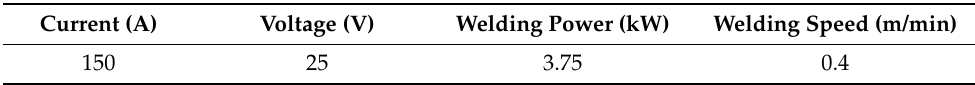
Table 3. FCAW parameters and experimental condition.